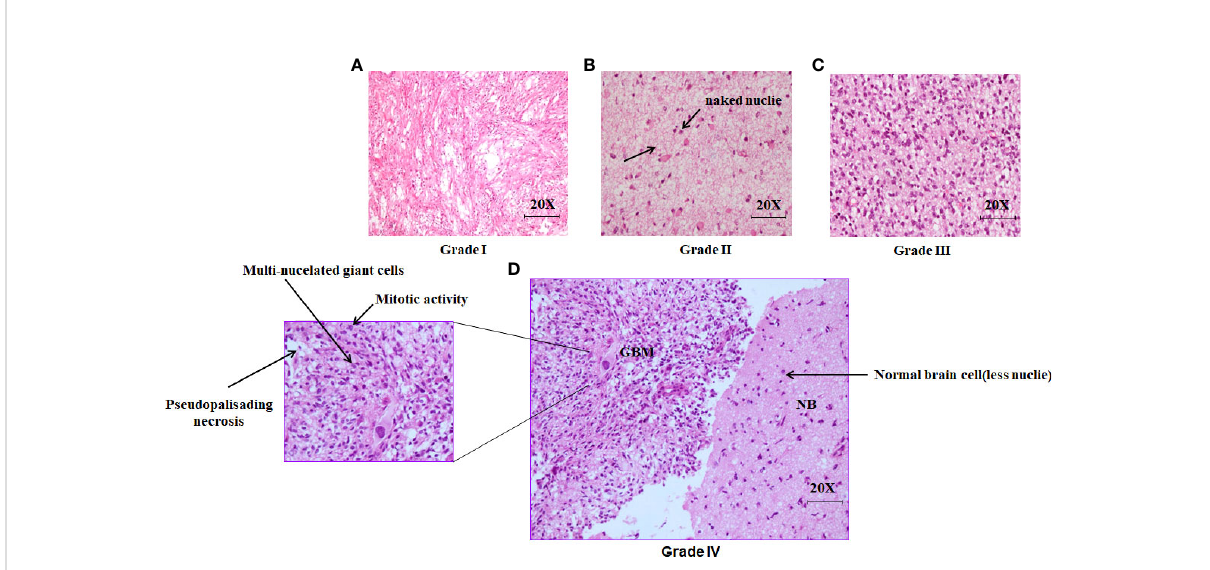
FIGURE 1 Histopathological analysis of excised brain tumor tissue stained with hematoxylin and eosin (H&E). (A) The light microscopic picture depicts the glioma grade I under 20X magni fi cation. (B) The Light microscopic picture depicts the glioma grade II under 20X magni fi cation with the formation of naked nuclei. (C) The light microscopic picture depicts the glioma grade III under 20X magni fi cation. (D) The light microscopic picture depicts the glioma grade IV (GBM) along with one portion of normal brain tissue in the right under 20X magni fi